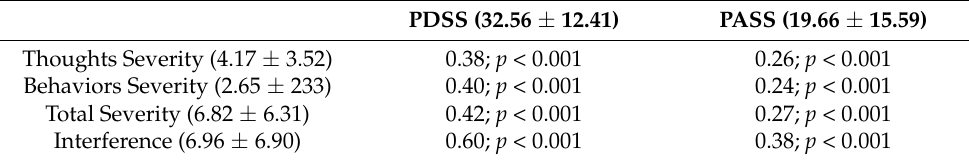
Table 2. Spearman coefficient correlations of POCS with PDSS and PASS